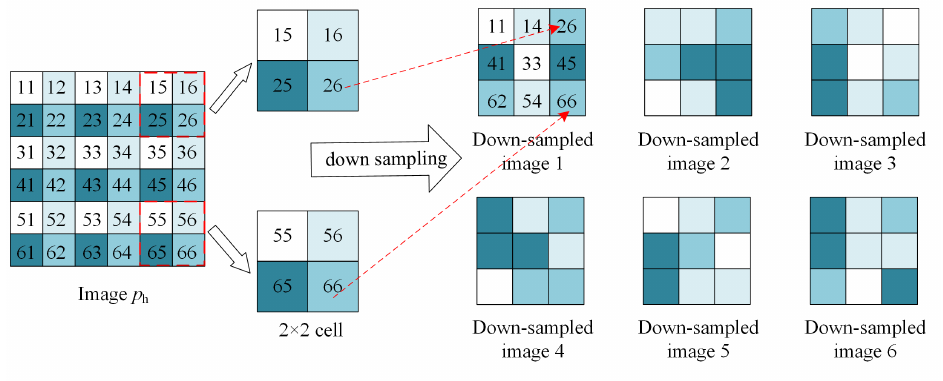
Figure 5. Example of the down-sampling images with the randomly selected down-sampled